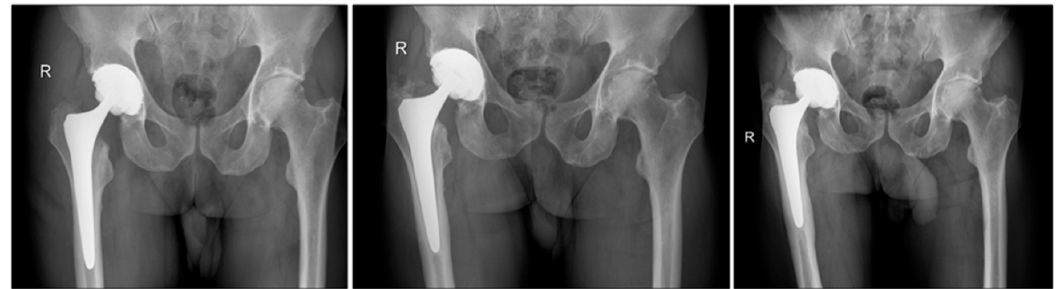
Figure 4. Observed progressive radiolucent lines in anteroposterior view of the pelvic.